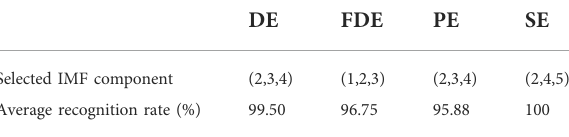
TABLE 4 The highest average recognition rates of four kinds of entropy under